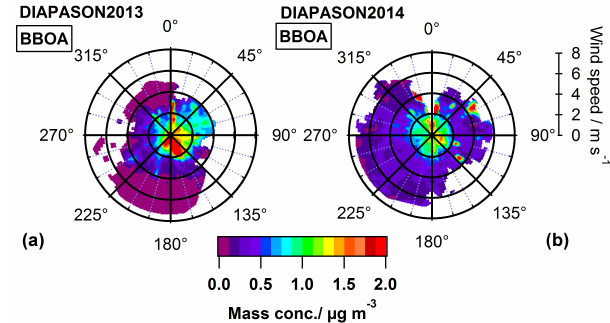
Figure 9. Submicron BBOA mass concentrations (colour coded) as a function of local wind direction ( ◦ ) and speed (ms − 1 ) for DIA- PASON2013 (left) and DIAPASON2014